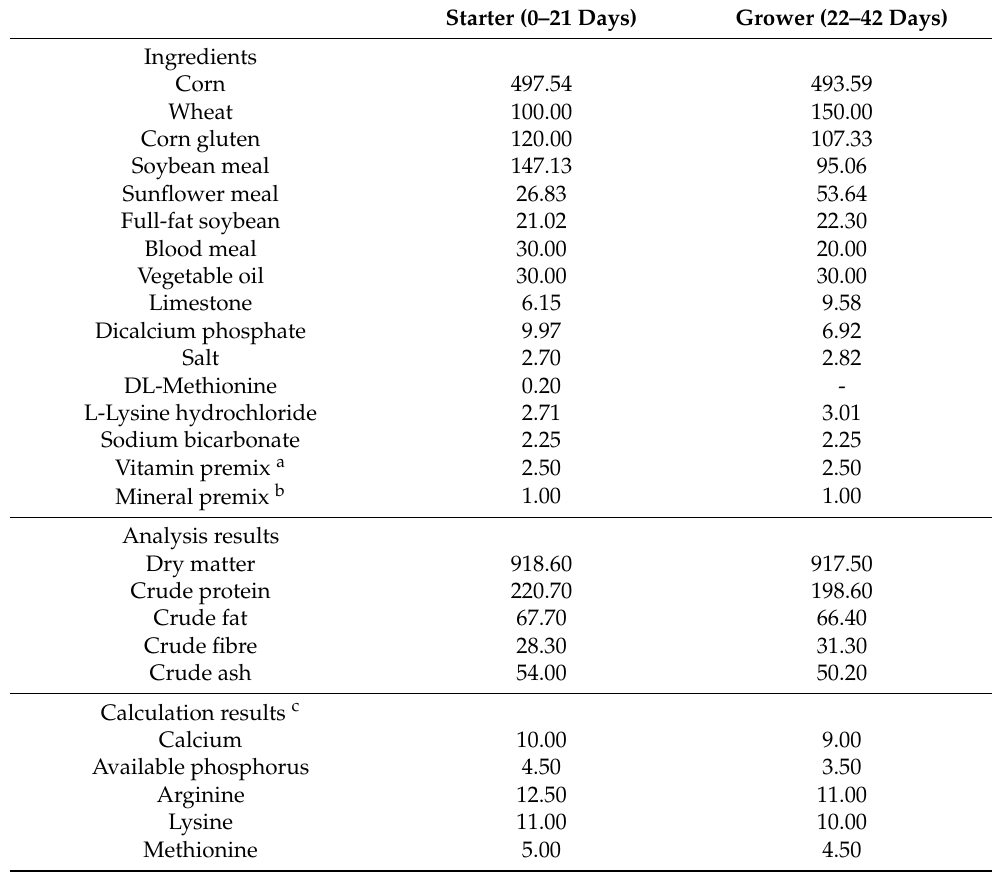
Table 1. Ingredients and chemical composition of the basal diets